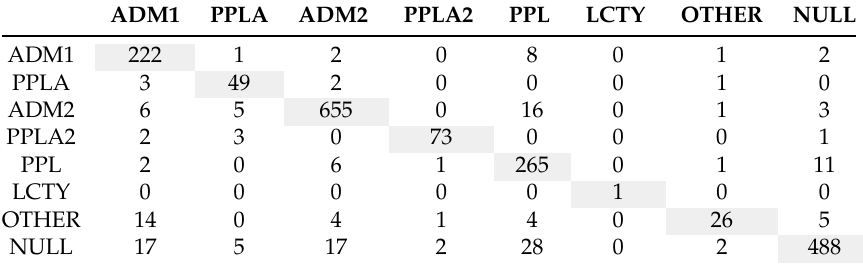
Table 4. Confusion matrix for geo-entity class assignment after dynamic disambiguation. The geographic levels follow the GeoNames convention (www.geonames.org/export/codes.html, last access 20 August 2020).